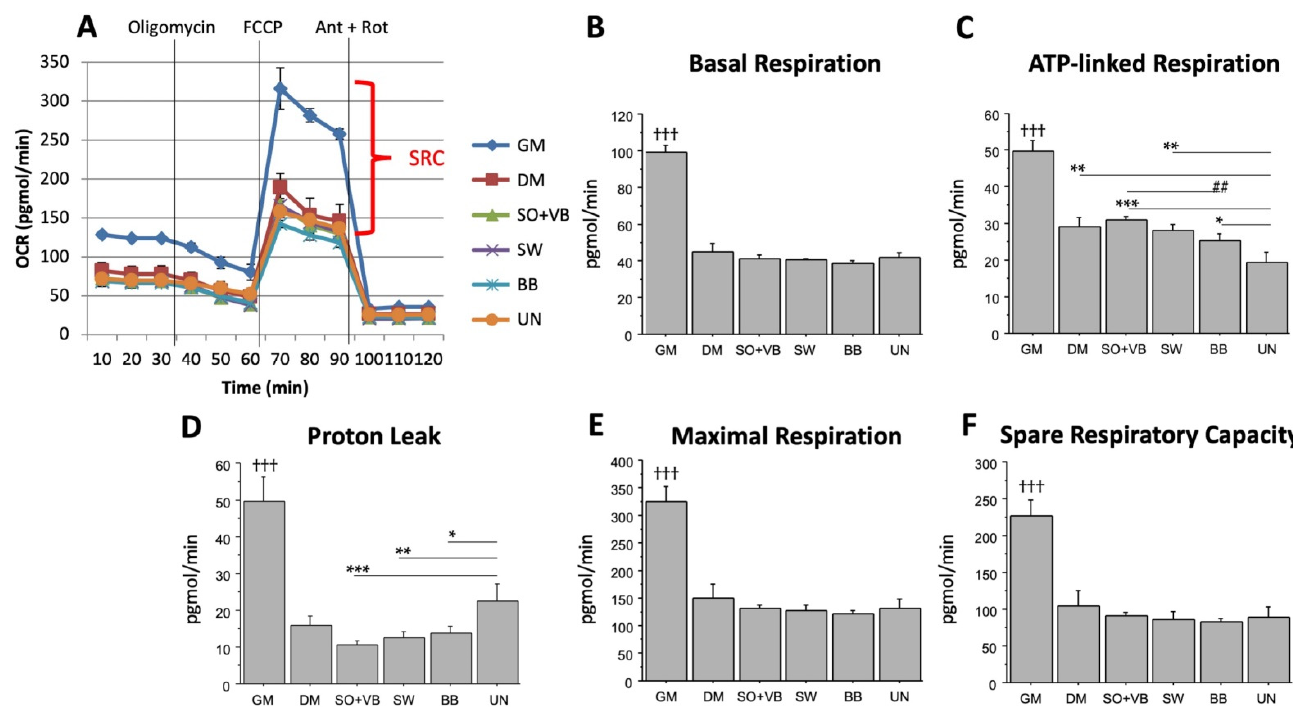
Figure 2. Oxygen consumption rate (OCR) measured in differently trained sera-treated LHCN-M2 cells in real time under basal conditions and in response to the following inhibitors: oligomycin, carbonylcyanide-4-(trifluoromethoxy)-phenylhydrazone (FCCP), antimycin A and rotenone (Ant + Rot). ( A ) Bioenergetic profile; SRC (spare respiratory capacity) in GM cultured cells is reported for explanatory purposes; ( B ) basal respiration (before addition of oligomycin); ( C ) ATP-linked respiration (calculated as the difference between basal and after oligomycin addition rate); ( D ) proton leak (calculated as difference between oligomycin and Ant + Rot rate); ( E ) maximal respiration (calculated as the difference between FCCP and Ant + Rot rate); and ( F ) spare respiratory capacity (calculated as the difference between maximal respiration and basal respiration). Data expressed as mean ± SEM of four independent experiments. Data comparison between groups was performed using the Student’s t -test. ††† p < 0.001 GM vs. all treated cells; *** p < 0.001; ** p < 0.01; * p < 0.05 vs. UN; ## p < 0.01 vs. SO + VB.